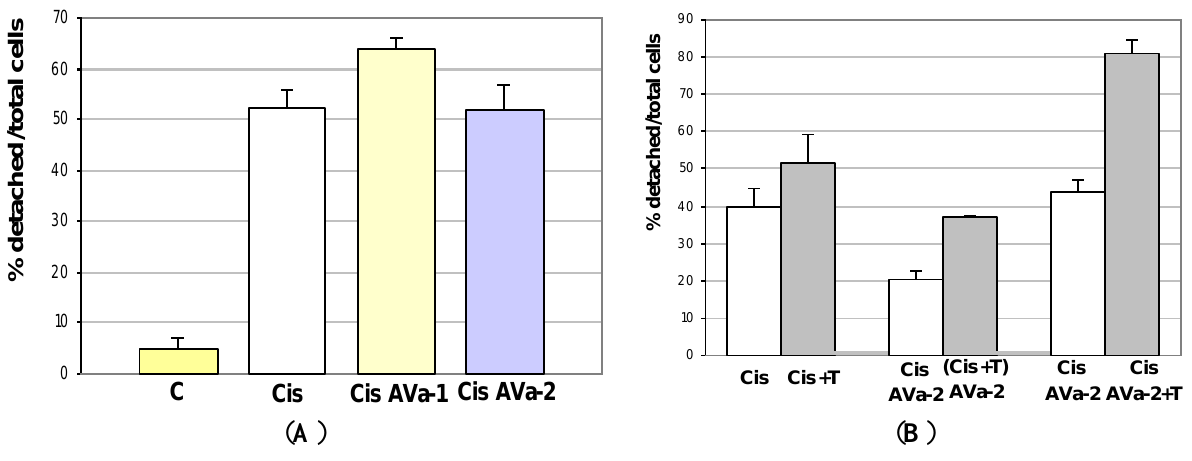
Figure 12. ( Panel A, up ): Me665/2/21 melanoma cells were treated for 48 h with cisplatin (1 μg/mL) or with cisplatin-loaded AVa hydrogel (30 μg/mL). ( Panel B, down ): Me665/2/21 melanoma cells were treated for 48 h with cisplatin with or without Temsirolimus, in diverse experimental conditions where drugs are in the native forms or loaded in AVa-2 hydrogel. Cell death is expressed as percentage of floating cells on total cells. All the results were statistically significant (p <